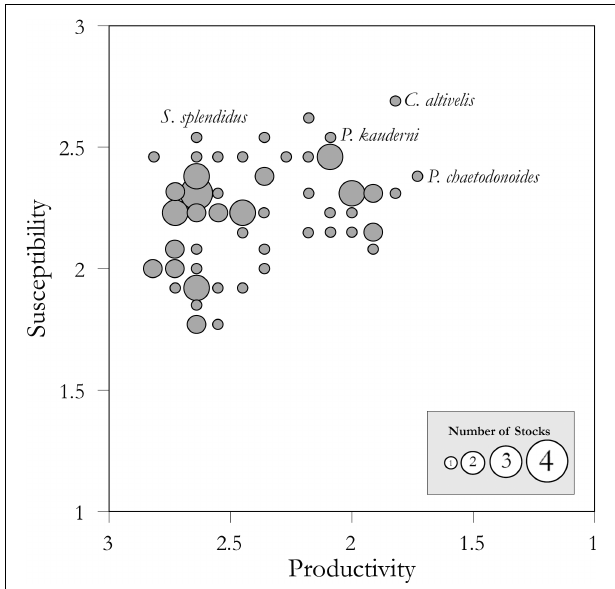
FIGURE 1 | Scatterplot of productivity versus susceptibility scores for 72 coral reef fish stocks as estimated by PSA. Circle size corresponds to the number of stocks at that position on the graph (see inset legend). Scientific names of the stocks highlighted in the text are noted. Following standard PSA methods from Patrick et al. (2009), the x-axis scale is reversed (from high to low